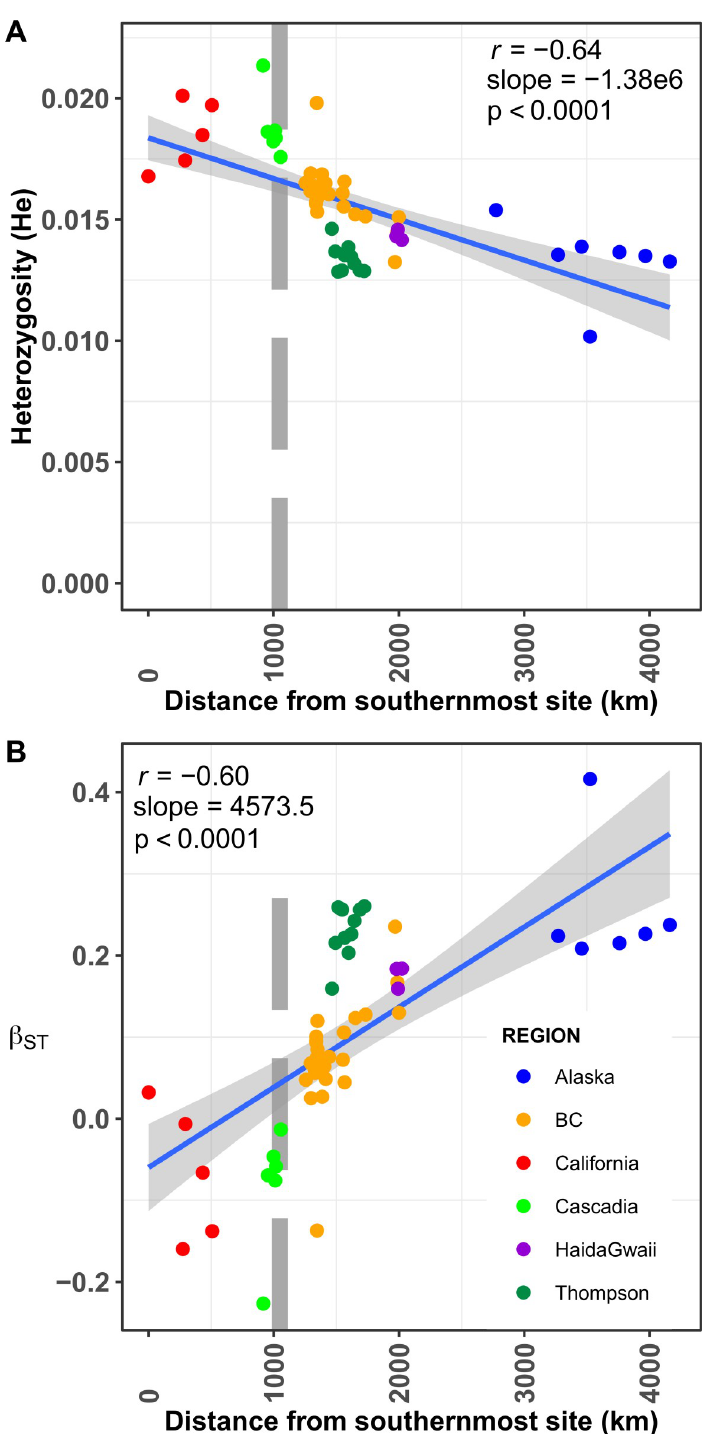
Fig 2. Genetic diversity and differentiation. A) Linear relationship between expected heterozygosity and distance from the southernmost population located in California. B) Linear increase in genetic differentiation as measured by β ST as a function of the distance from the southernmost population located in California. Negative values indicate the most likely ancestral population. The relationship in A and B was tested using linear models. The grey vertical bar in panel A and B indicates the approximate location of the southern limit of the ice-sheet at the end of the last glacial maximum. The coefficient of correlation (r) is indicated for each plot. The grey shaded area along the regression line corresponds to the 95% confidence level interval obtained from the linear models applied to each